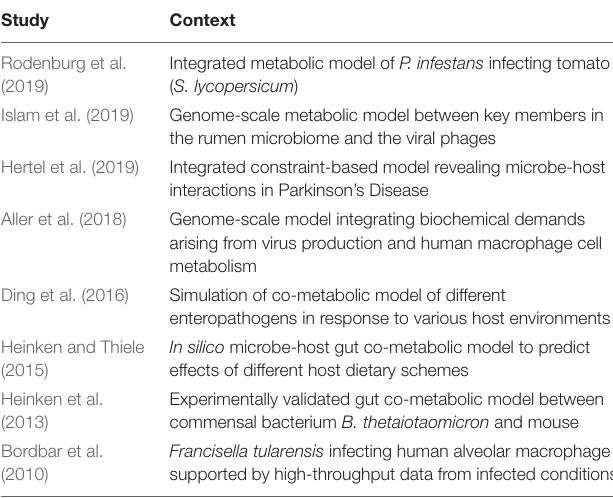
TABLE 1 | Studies using genome-scale metabolic models and constraint based approaches to infer mechanistic co-metabolic interactions between microbial and host